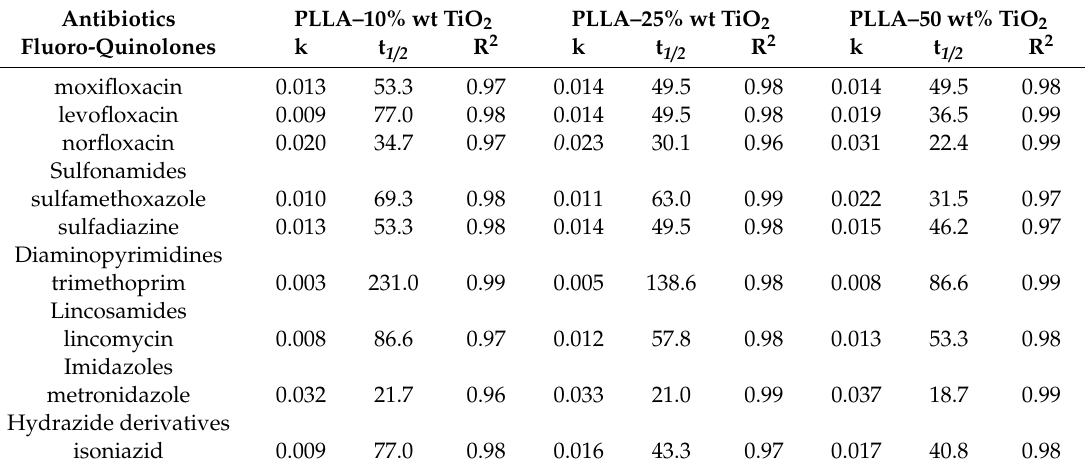
Table 2. E ff ect of TiO 2 loading on kinetic parameters during the photocatalytic degradation of